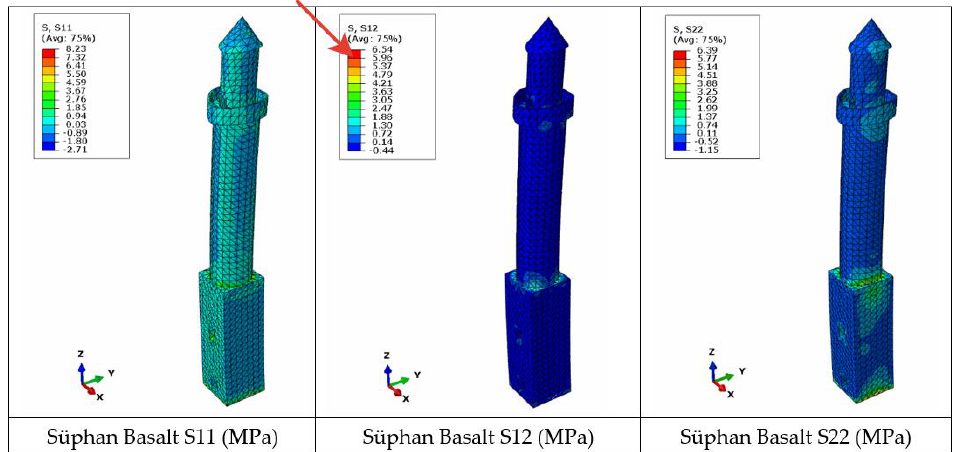
Figure 13. Stress diagrams for Süphan Basalt (H = 25.40 m).